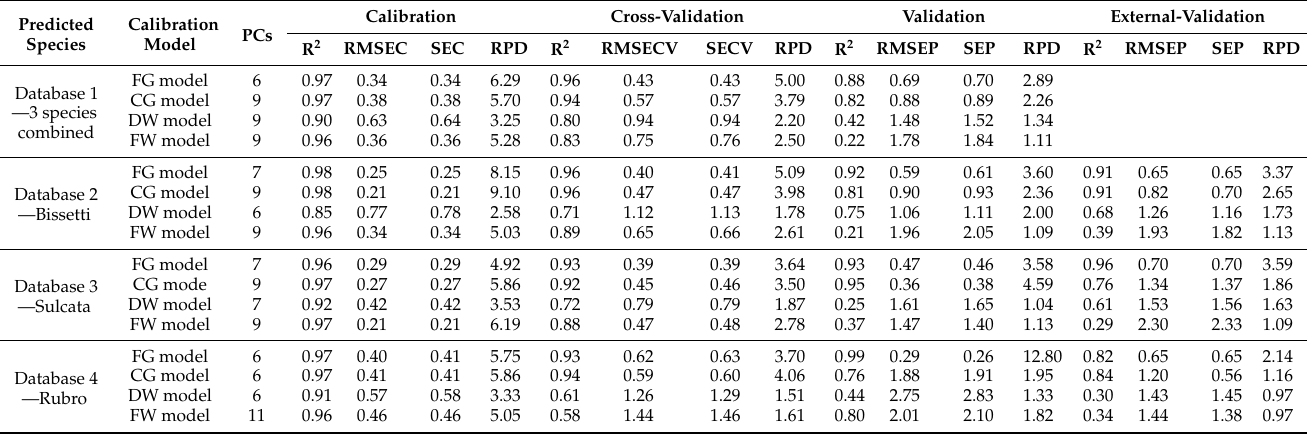
Table 2. Prediction results of the PLSR models for predicting the quantity of crude protein across bamboo species. The calibration model of each processing mode was applied to its corresponding sample type in all databases. In Database 1, spectra from all bamboo species were combined to generate calibration models. Calibration models for crude protein were built from Sulcata and Rubro and used to predict Bissetii in Database 2; models were built from Bissetii and Rubro and used to predict crude protein in Sulcata in Database 3, and models built from Bissetii and Sulcata were used to predict crude protein in Rubro in Database